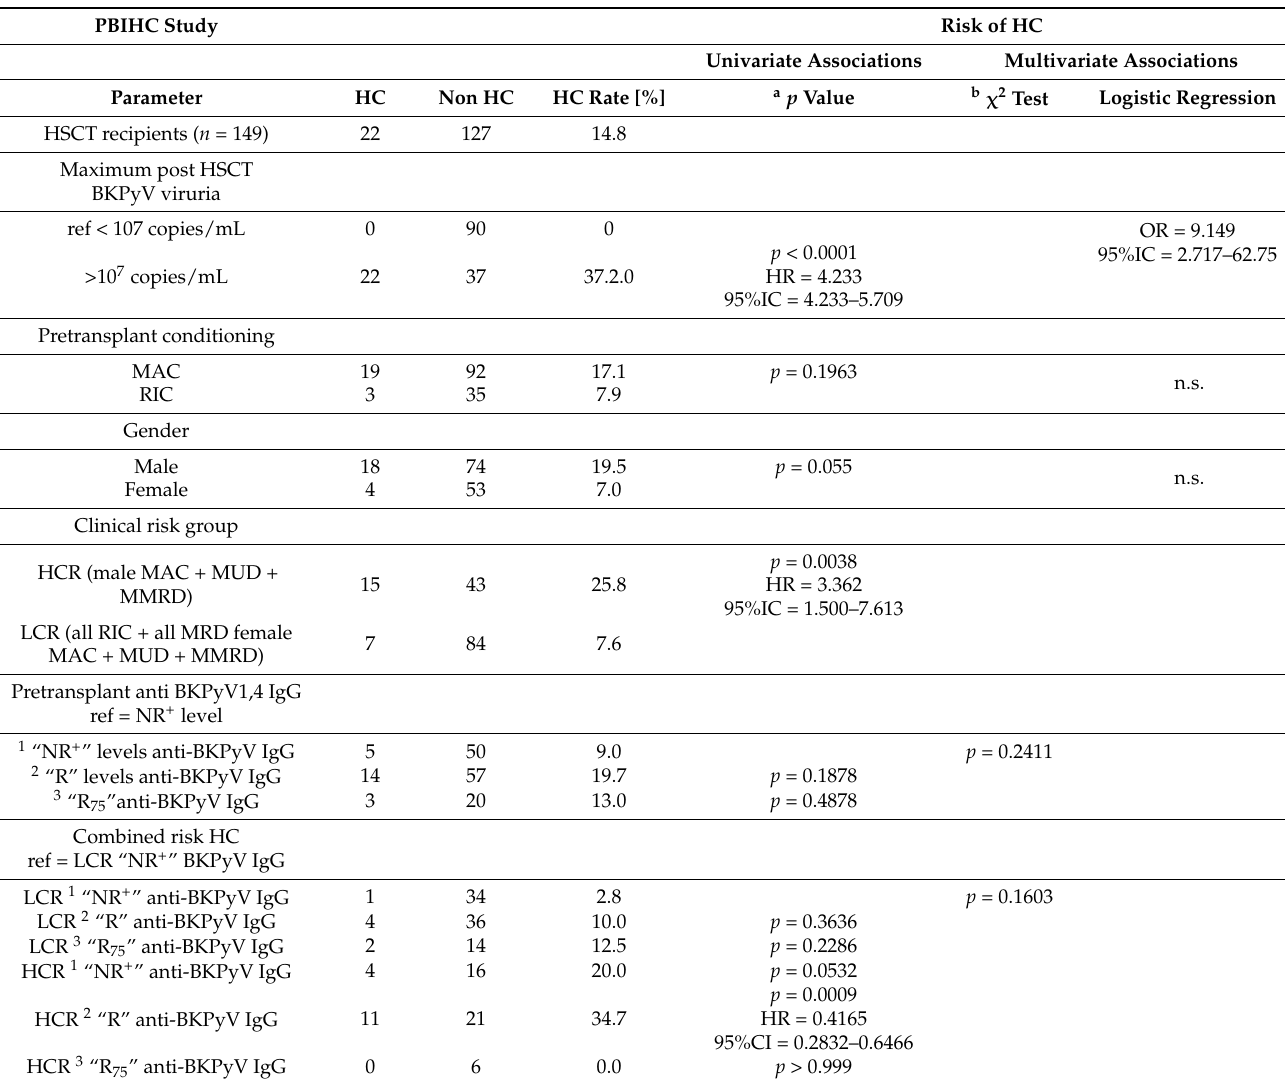
Table 2. Risk of HC in the PBIHC study cohort of HSCT recipients 2017–2020 ( n = 149) including clinical features and pretransplant BKPyV-specific antibodies.